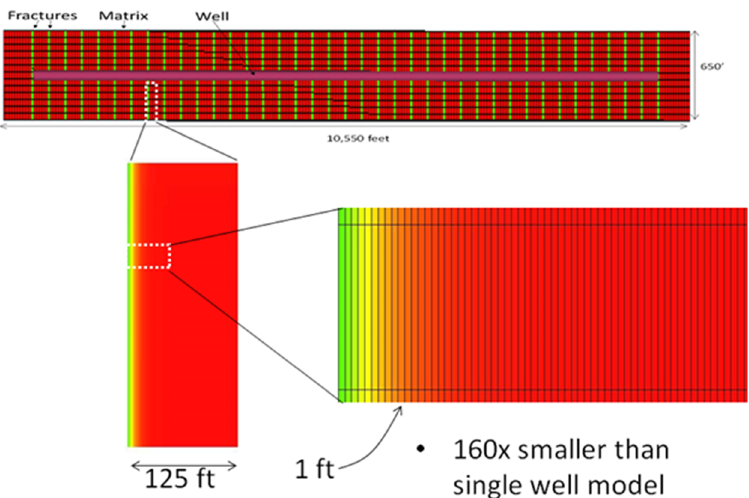
Figure 8. For grid sensitivity, a quarter-fracture model was created by cutting out a portion of the original grid. The new model was 1 / 160th the size of the original model, and it was regridded in the x-direction down to 1 ft grid sizes. The grid sizes in the y-direction (50 ft) and z-direction (8 ft) remained the same.